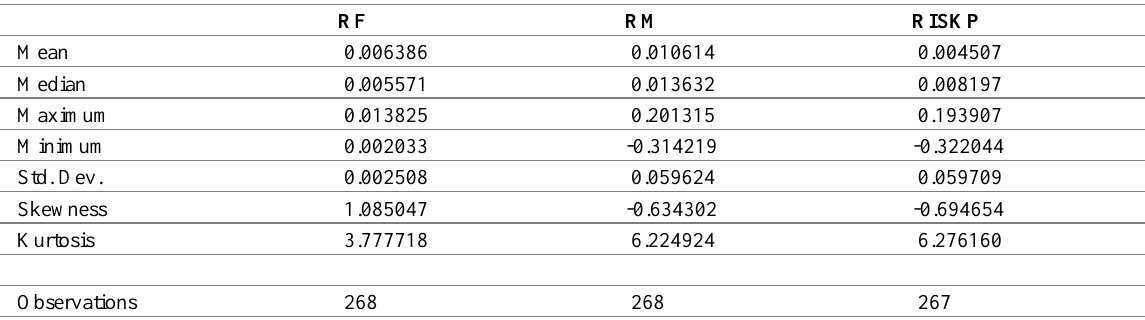
Table 2: Monthly Market Return, Risk-Free Interest Rate and Risk